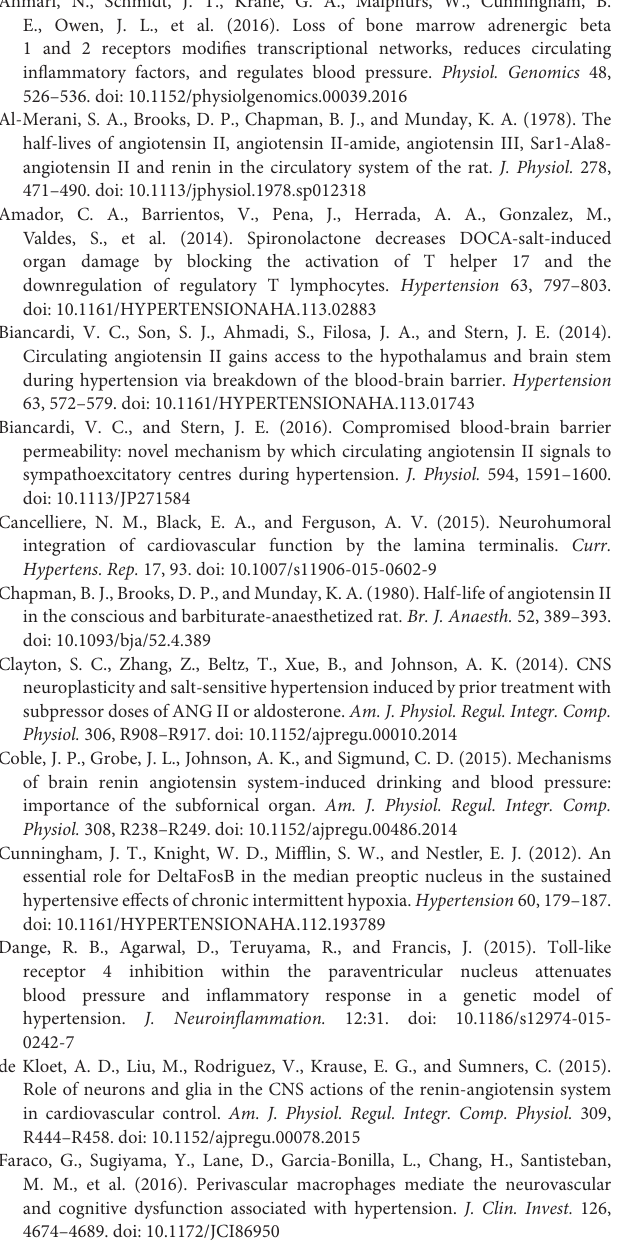
Figure S1 | Power spectral analysis of SBP signal at different time points following Ang II (red bars) and control saline injections (blue bars) in the WKY. (A) Very low frequency (VLF) of SBP. (B) High frequency (HF) of pulse interval (PI). (C) Low frequency (LF) to high frequency (HF) ratio. (D) Spontaneous baroreflex gain (sBRG) of pulse interval (PI). N = 6 per group, ∗ P < 0.05. Figure S2 | ELISA plate showing the individual results for cytokines measured in the PVN at 1 h (A) and 24 h (B) post saline and Ang II injections.